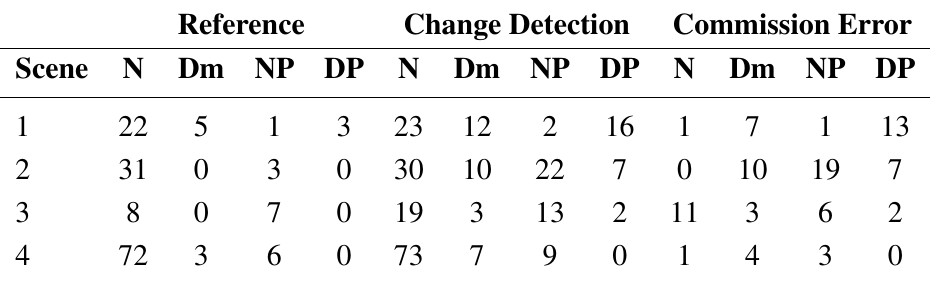
Change detection results: N = new buildings, Dm = demolished buildings, NP = new building-parts and DP = demolished building-parts.